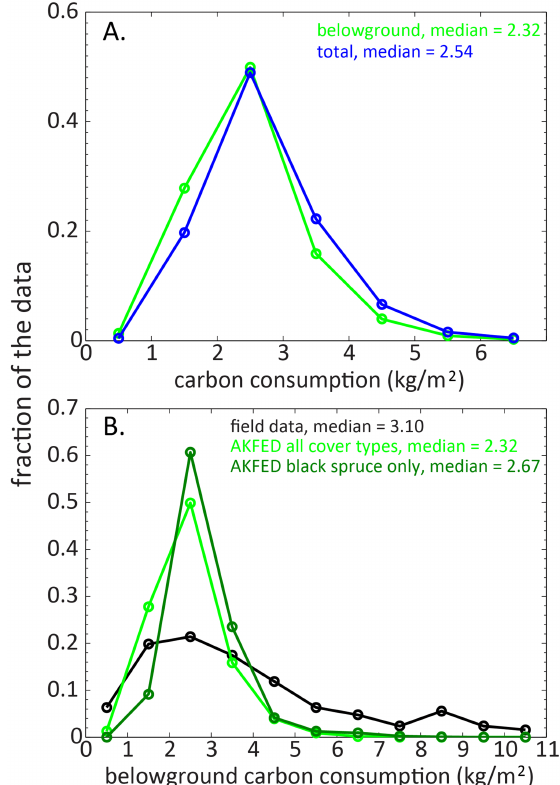
Figure 9. Distribution of (a) belowground, aboveground and to- tal carbon consumption from the Alaskan Fire Emissions Database (AKFED) between 2001 and 2012, and (b) belowground carbon consumption of field data and AKFED. Data is plotted in the middle of interval boundaries on the x